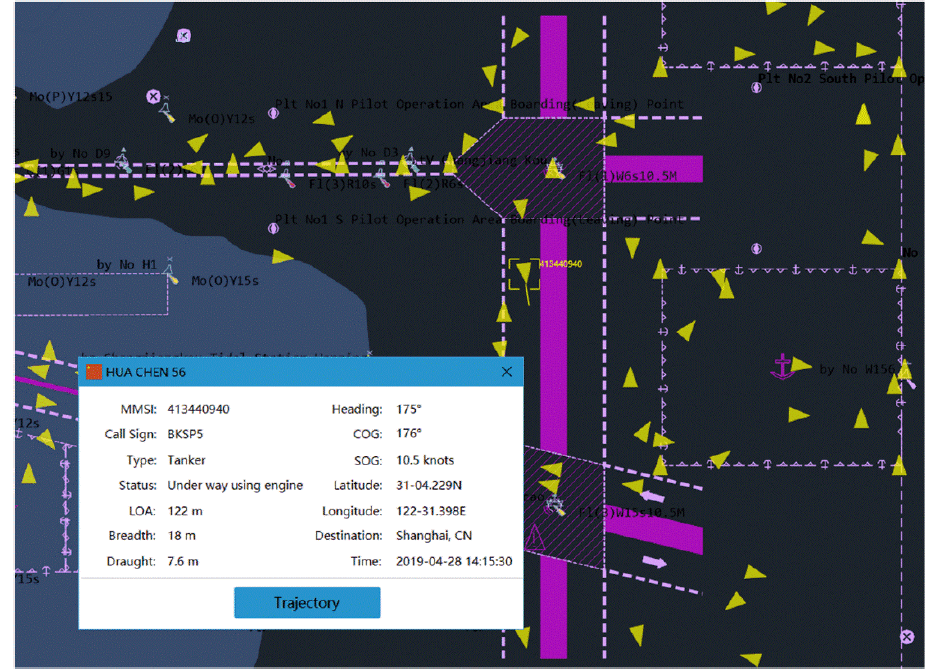
Figure 7. An example of multi-vessel trajectory playback in the Yangtze River Estuary at a certain time on 28 April 2019.